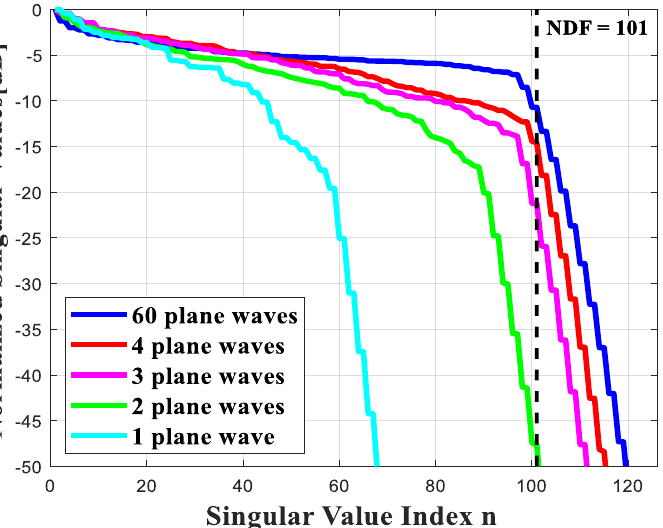
Figure 16. Comparison of the behavior of the normalized singular values of the linearized inverse scattering operator for different numbers of impinging plane waves for a circumference ID.